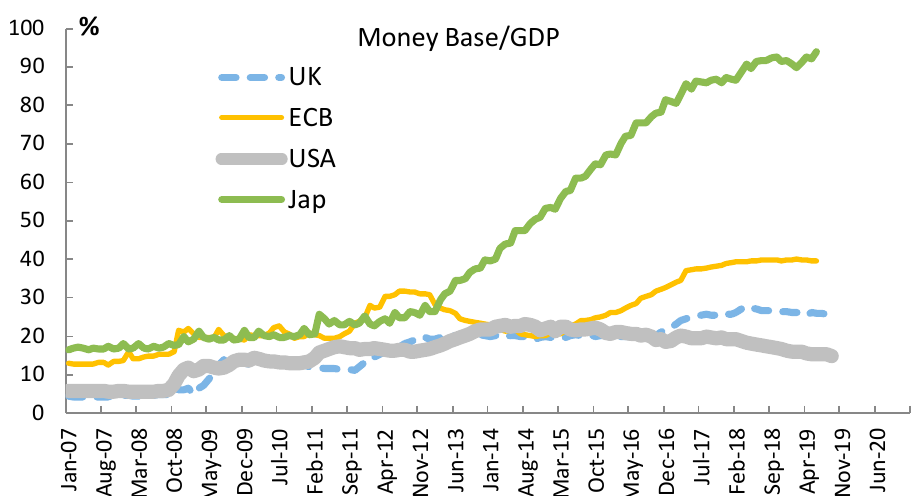
Figure 1. Money Base-to-GDP Ratios. Source: Thomson Reuters.